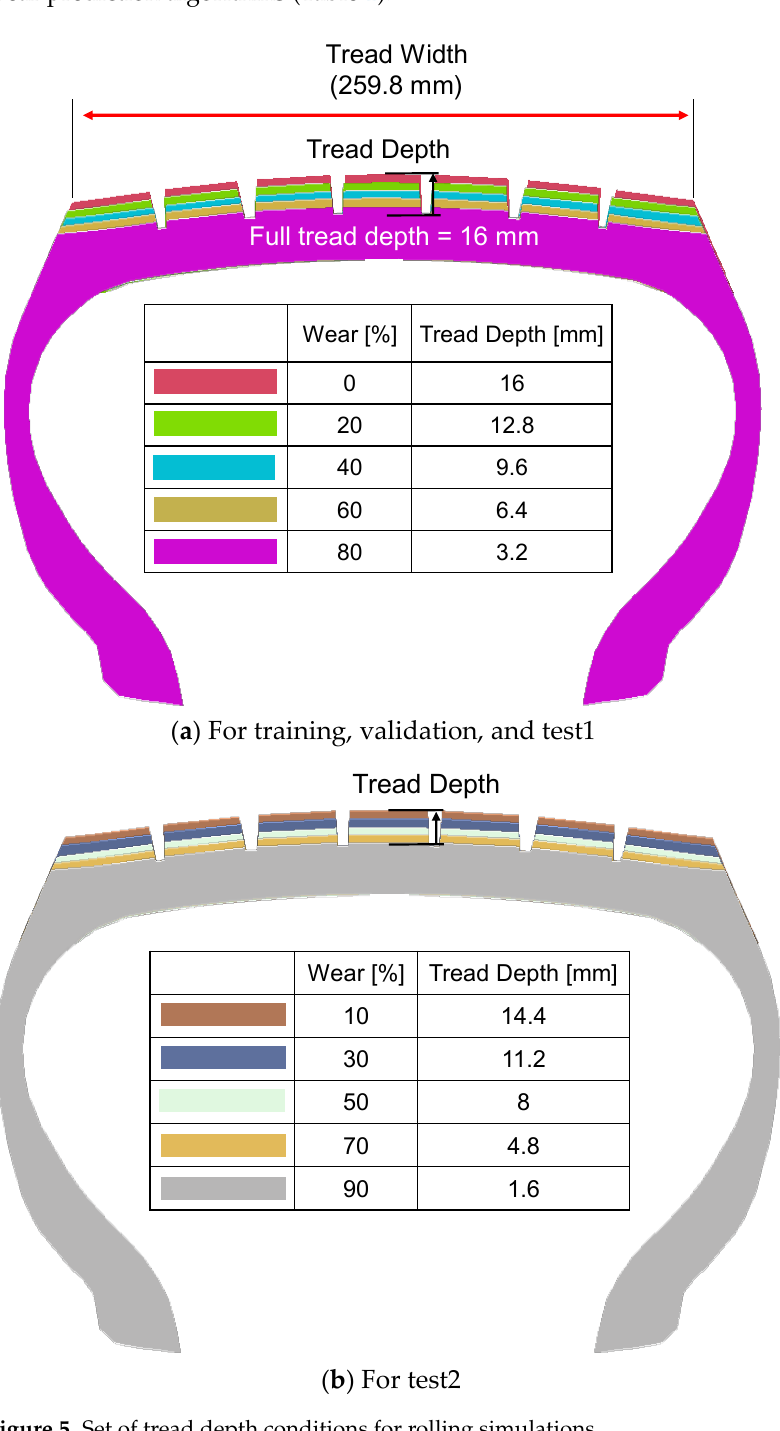
Table 1. Simulation parameters for training machine learning algorithms for tire wear prediction.